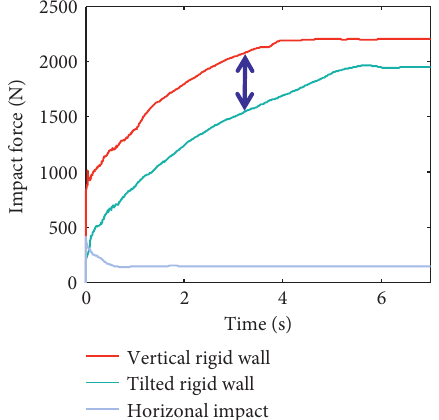
Figure 10: History curve of impact force produced by dry granular flow against under different slope angles and different rigid wall types.